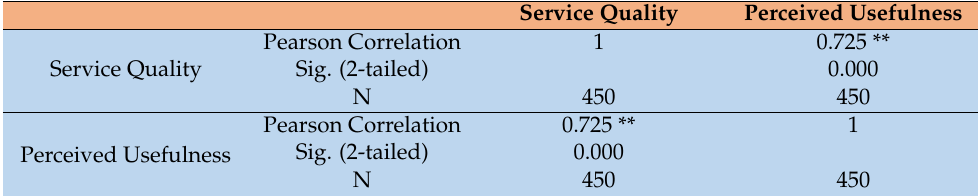
Table 11. Results of the correlation analysis for hypothesis 6